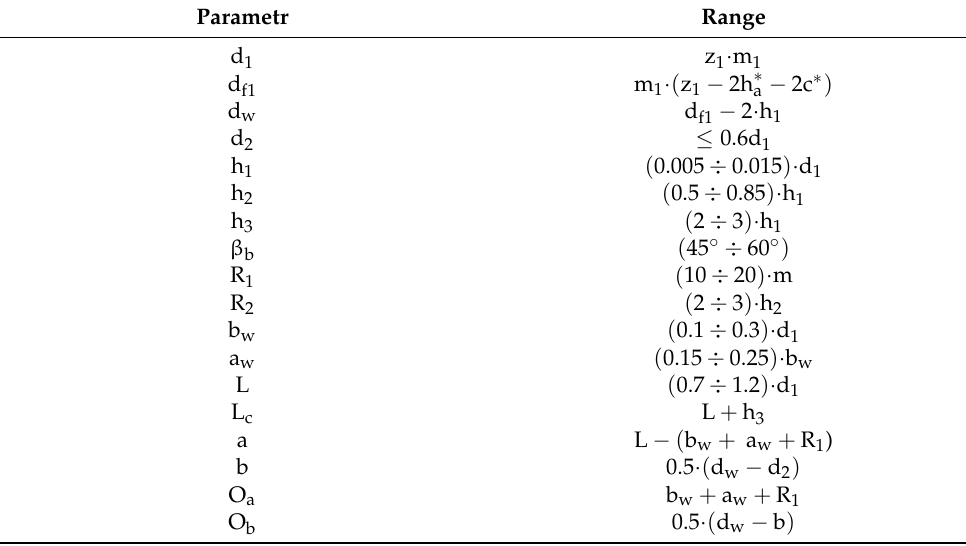
Table 2. Main geometric parameters for the new shape of flexspline (variant X), where: z 1 =